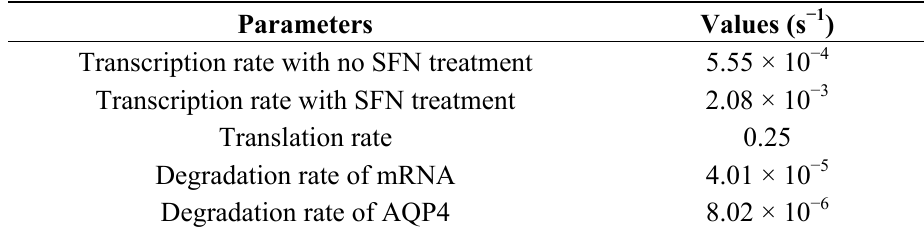
Table 2. Kinetic rates of AQP4